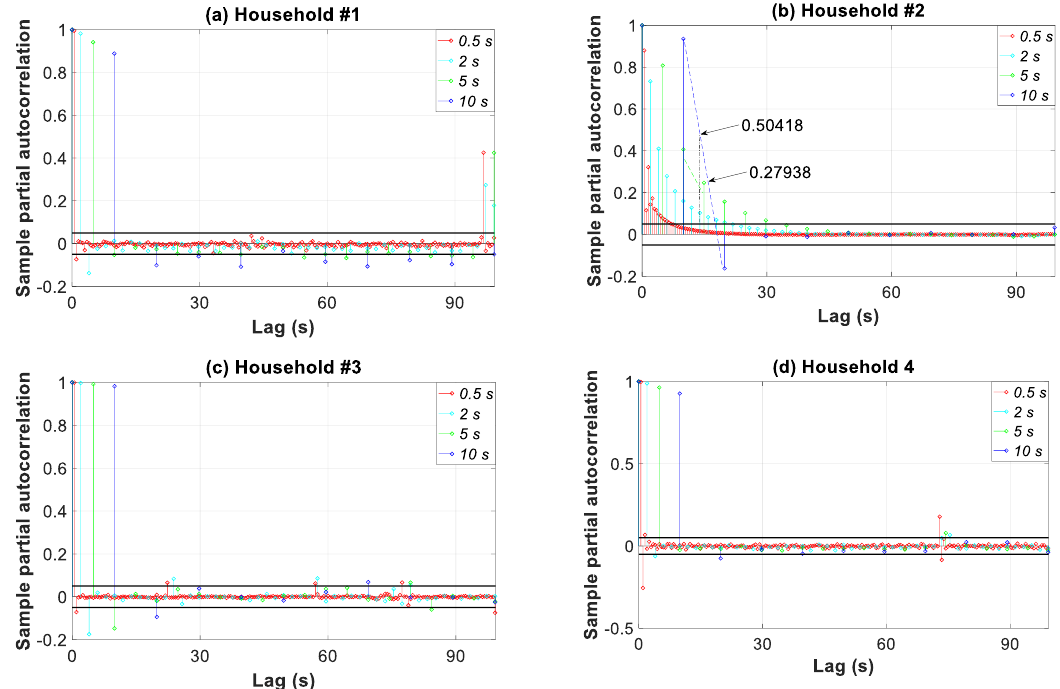
Figure 15. Partial autocorrelation function of the consumption load profile in households #1 to #4 for four data